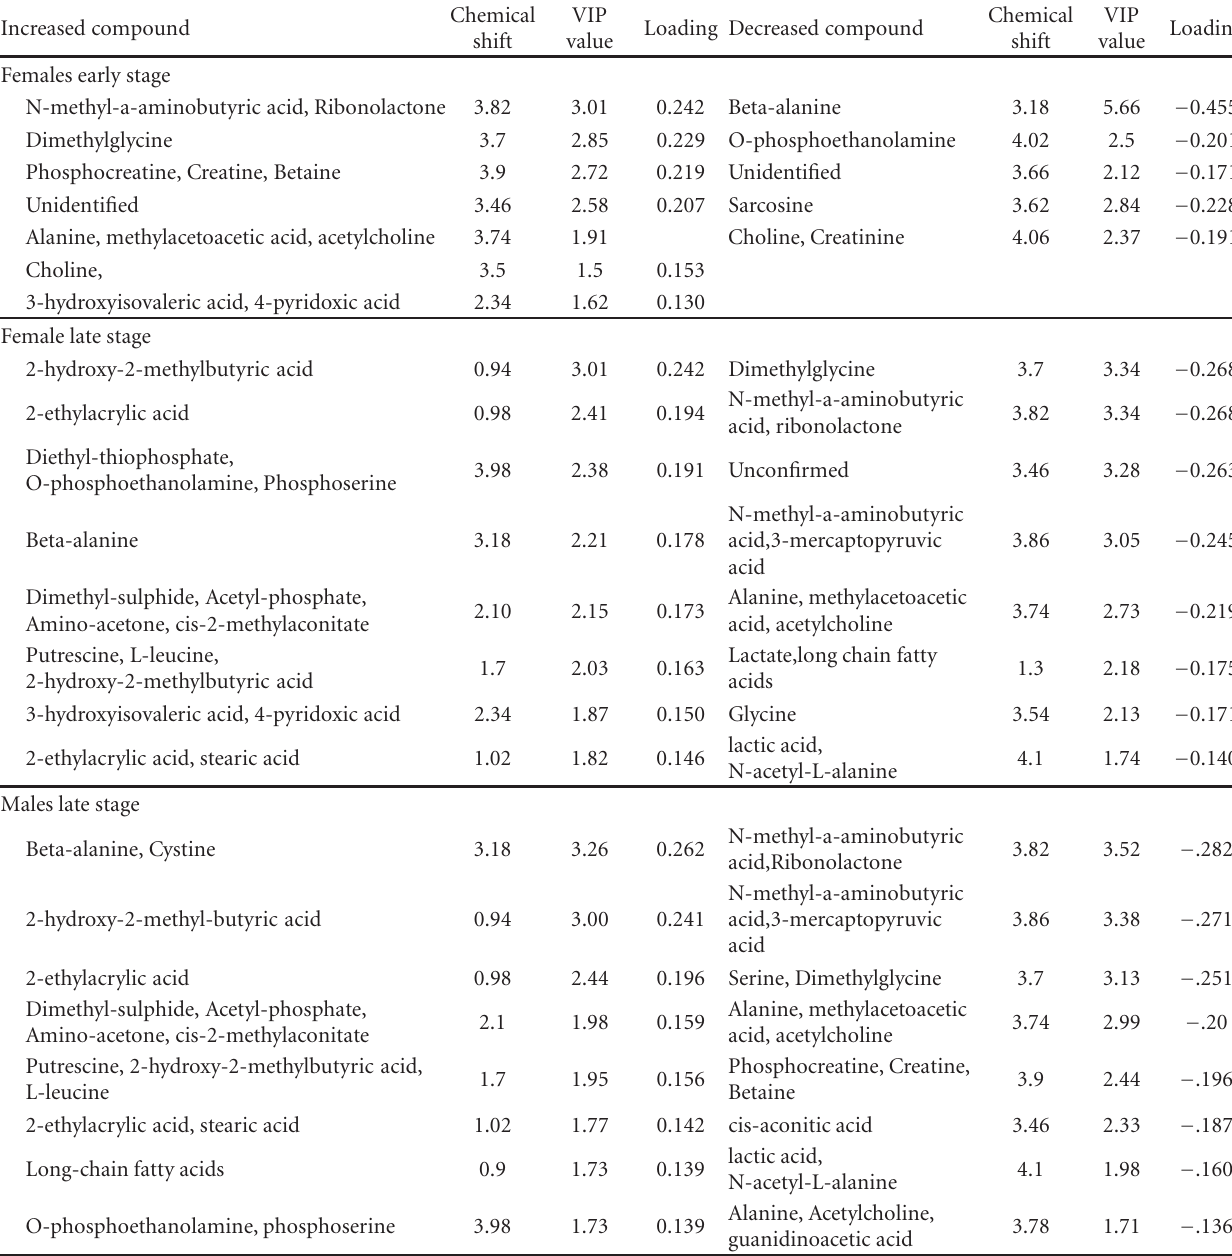
Table 1: Metabolites perturbed in the mouse liver during infection with P. berghei ANKA. Italicized metabolites could not be confirmed. Cystine, serine and phosphoserine could not be confirmed because their crosspeaks occur in very crowded regions of the spectrum. Presence of fatty acids cannot be confirmed due to low